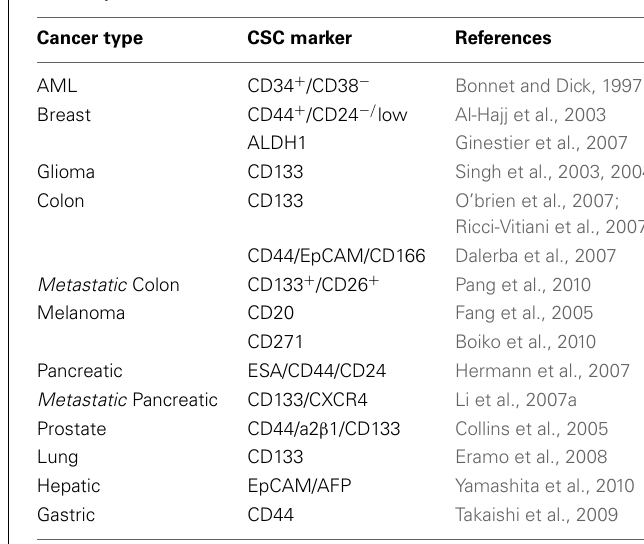
Table 1 | Representative cell surface markers for human